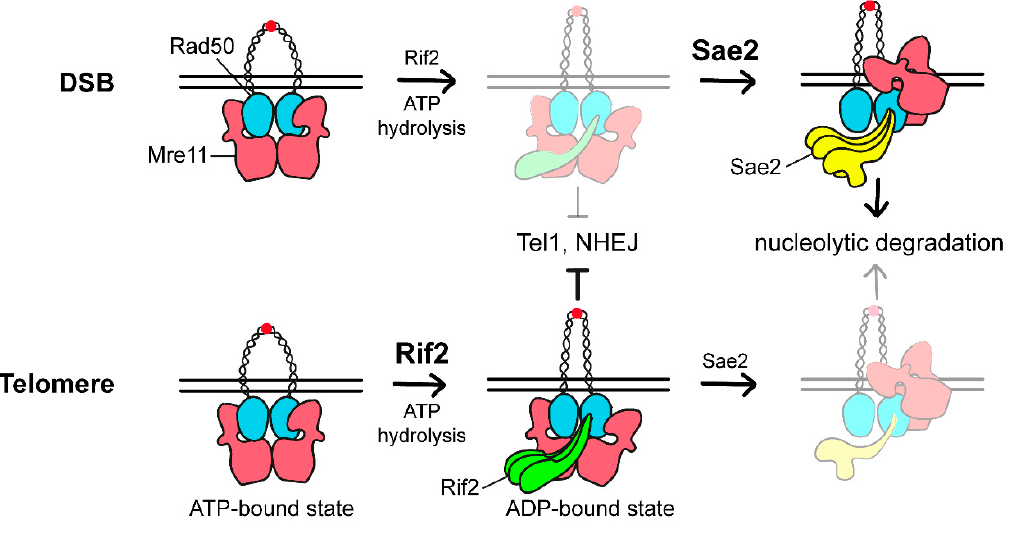
Figure 4. Model of regulation of MRX activity at DSBs and telomeres. In the ATP-bound state, the dsDNA is inaccessible to Mre11. Upon ATP hydrolysis by Rad50, the two Rad50 coiled coils zip up and Mre11 moves to the side of Rad50 dimer where it can act as endonuclease. At the DSB, the excess of Sae2 compared to Rif2 leads to Sae2 binding to the Rad50-Mre11 interface. This interaction stabilizes Mre11-Rad50 in a conformation that is proficient to cleave DNA. At telomeres, the excess of Rif2 compared to Sae2 antagonizes Sae2 binding to Rad50 and stabilizes a post hydrolysis ADP-bound state that is not competent for NHEJ, Tel1 activation, and DNA cleavage. Xrs2 is not represented. Rif2 functions in inhibiting Mre11 endonuclease, Tel1 activation, and NHEJ depend on a small Rif2 region of as little as 34–40 amino acids, called MIN (MRN-INhibitor)